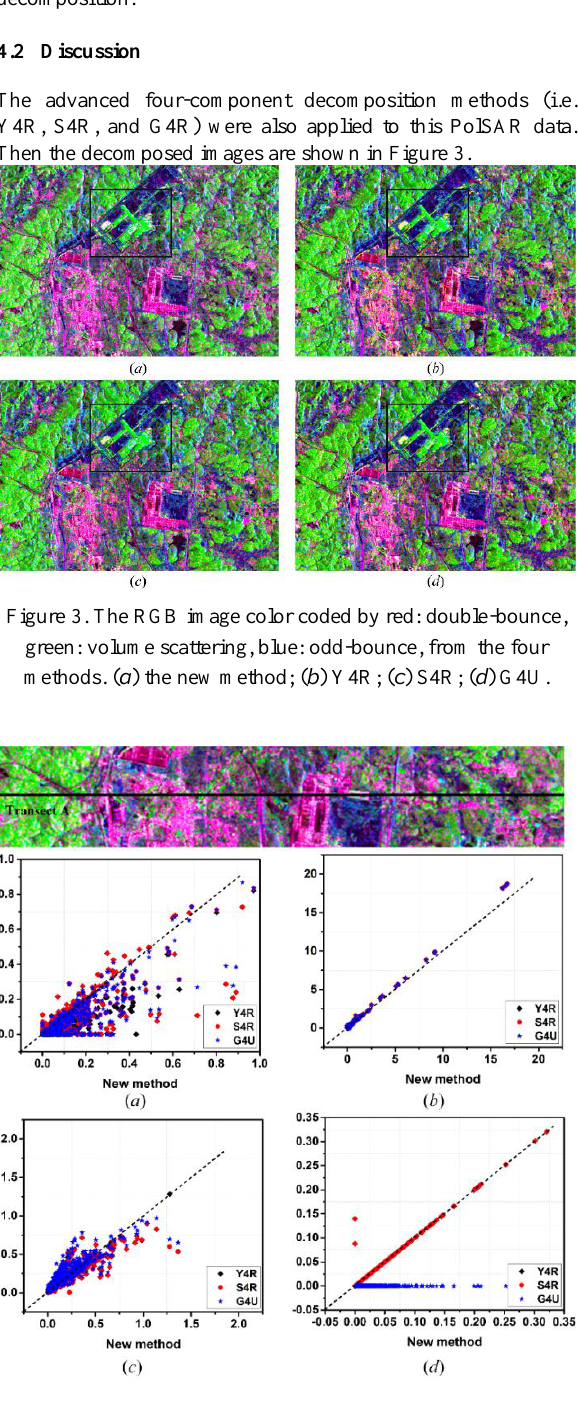
Figure 4. The quantitative comparison among the four methods. (a) Odd-bounce scattering; (b) Double-bounce scattering; (c) Volume scattering; (d) Helix